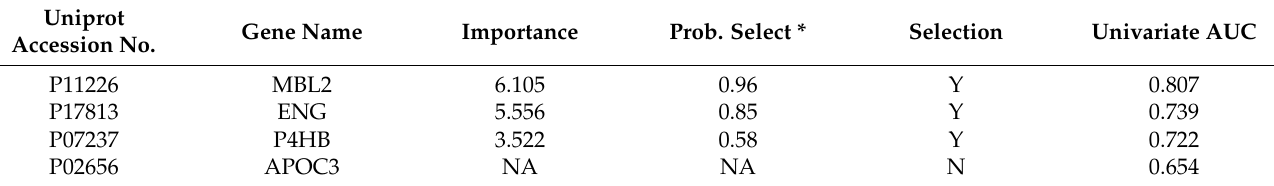
Table 2. Selected feature proteins by AUC-based RF backward elimination. Uniprot Accession